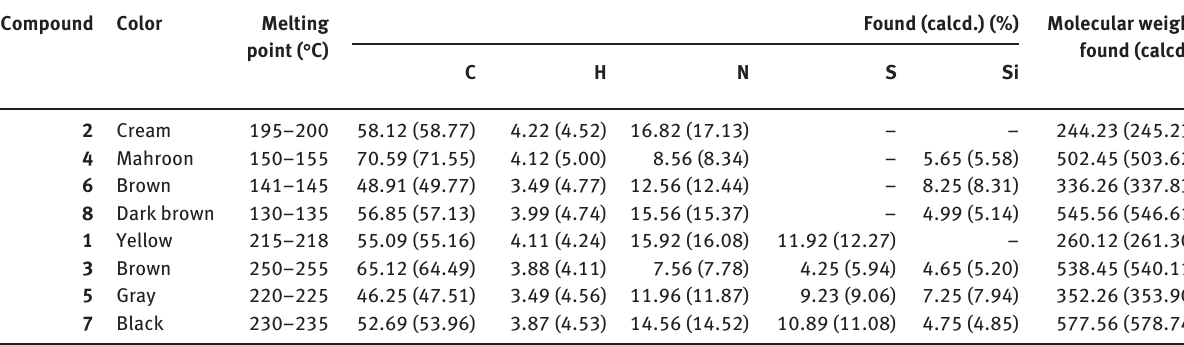
Table 6 Analytical data and physical properties of the ligands and their silicon complexes. Compound Color Melting Found (calcd.) (%) Molecular